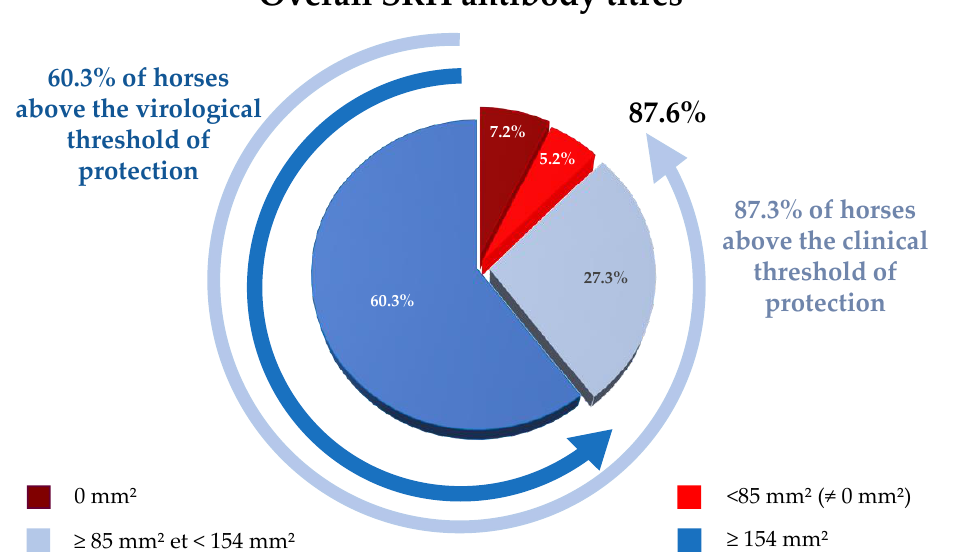
Figure 1. Overall single radial hemolysis (SRH) antibody response for serum samples collected between 2017 and 2018 (all four French regions combined). SRH titers below the clinical protection threshold ( > 85 mm 2 ) are in red colors, titers above the clinical protection threshold are in light blue (85 mm 2 and < 154 mm 2 ), titers above the clinical and virus shedding protection threshold (154 mm 2 and above) are in